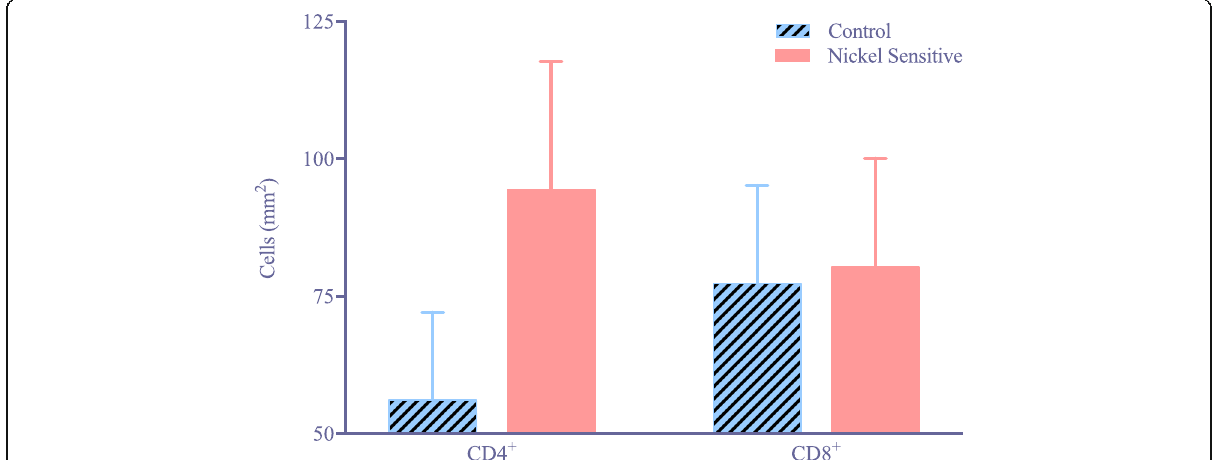
Fig. 3 Comparison of CD4 + and CD8 + T cell counts between control ( n = 13) and nickel sensitive ( n = 19) groups. Control patient synovial samples show a trend of less CD4 + counts relative to nickel sensitive samples. Error bars show standard